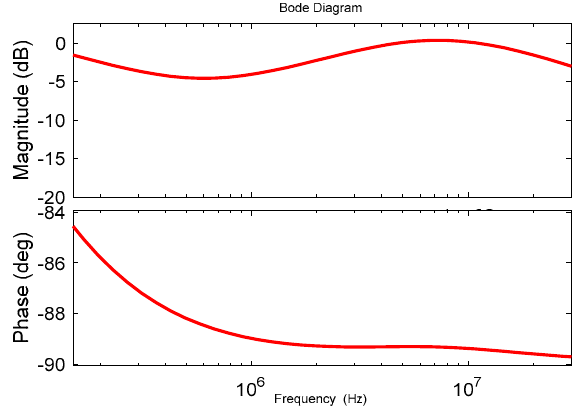
Figure 16. Bode diagram for CM interference.